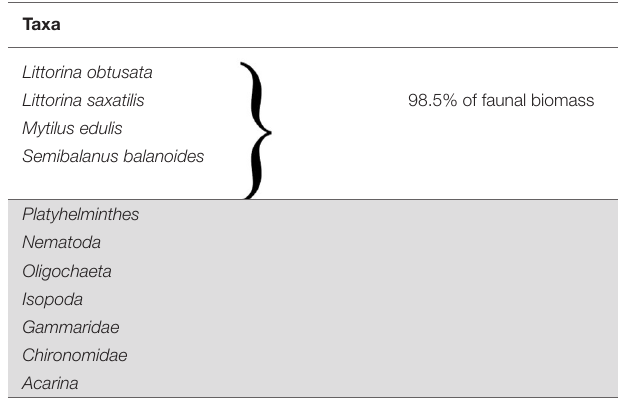
TABLE 3 | Faunal taxa of “Pre-experimental” community in the mid intertidal zone of inner Kobbefjord, SW Greenland, August